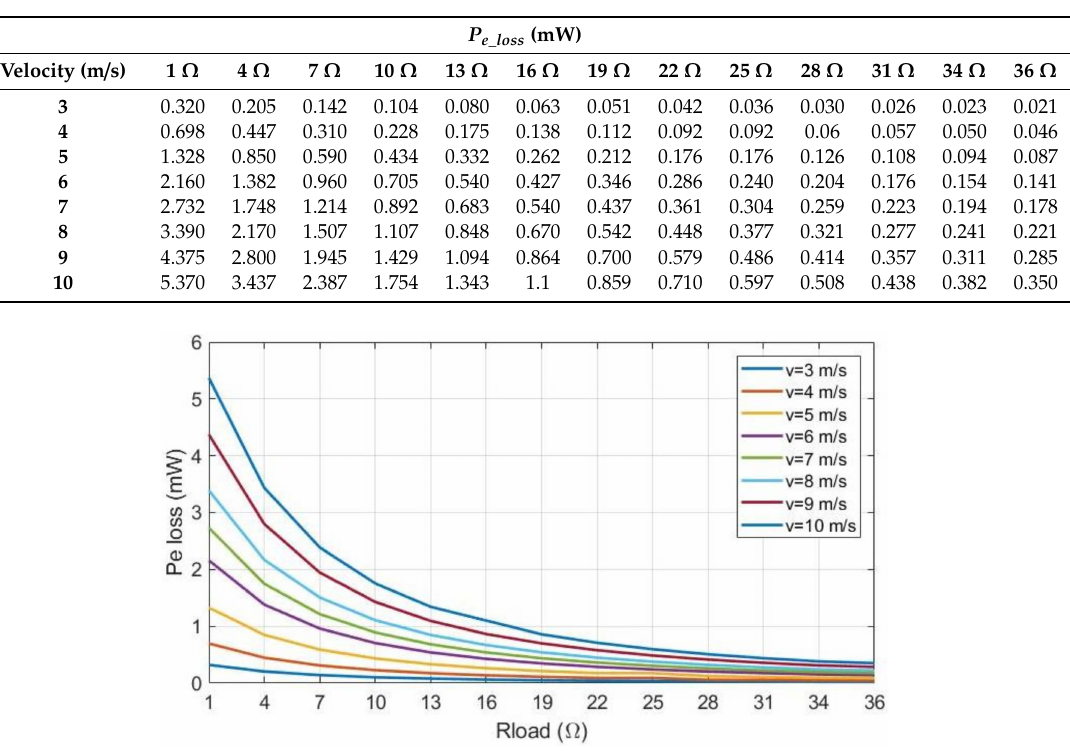
Table 7. Calculated harvester electric losses values for di ff erent loads and air velocities.